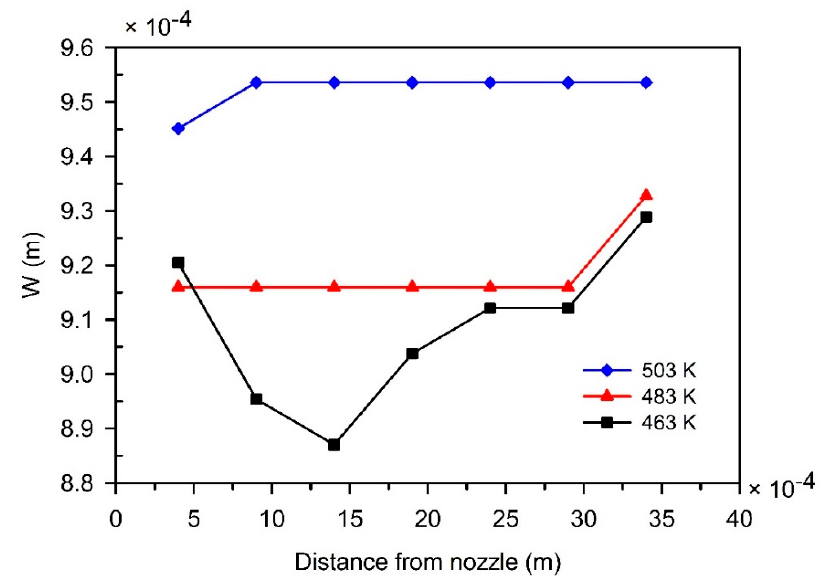
Figure 13. Widths of a strand along X (distance from the nozzle) with different nozzle temperatures. (Lines connecting symbols are for visual guidance).